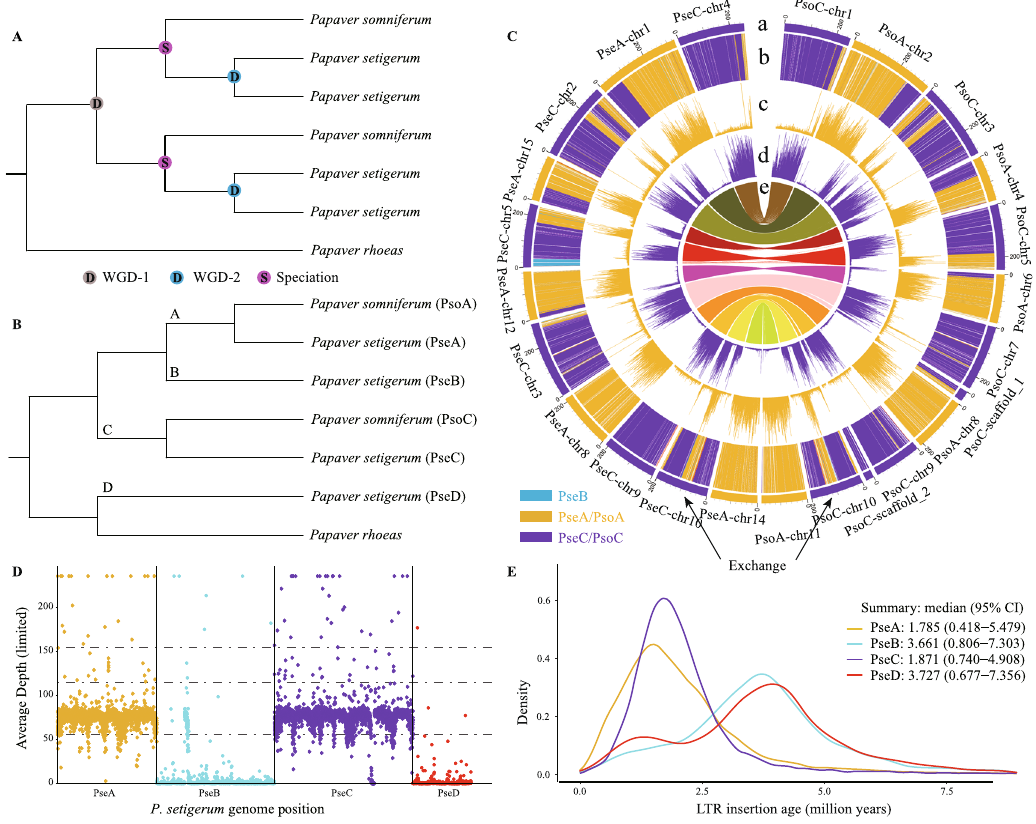
Fig. 1 | The origin and evolution of the subgenomes in the three studied Papaver species.A Phylogenomicrelationships among the subgenomesassuming the whole-genome duplication (WGD) model of Yang et al. 3 . B Tree topology recovered by gene trees, macro-synteny trees, and species/subgenome trees (see Supplementary Figs. 4, 5, 8 for details). The four subgenomes of P. setigerum are designated PseA, PseB, PseC and PseD; the two subgenomes of P. somniferum are designatedPsoAandPsoC,andtheirancestorsaredesignated A – D . C Circosplotof subgenome partitions of P. somniferum and P. setigerum genomes (more details in Supplementary Figs. 6, 7) indicates that PseA and PsoA, and PseC and PsoC share almost all subgenomic exchanges except a segment in PseC-chr5 that shows exchange with PseB. (a) Subgenome assignment of chromosomes based on the k -means algorithm. (b) Signi fi cant enrichment of subgenome-speci fi c k -mers